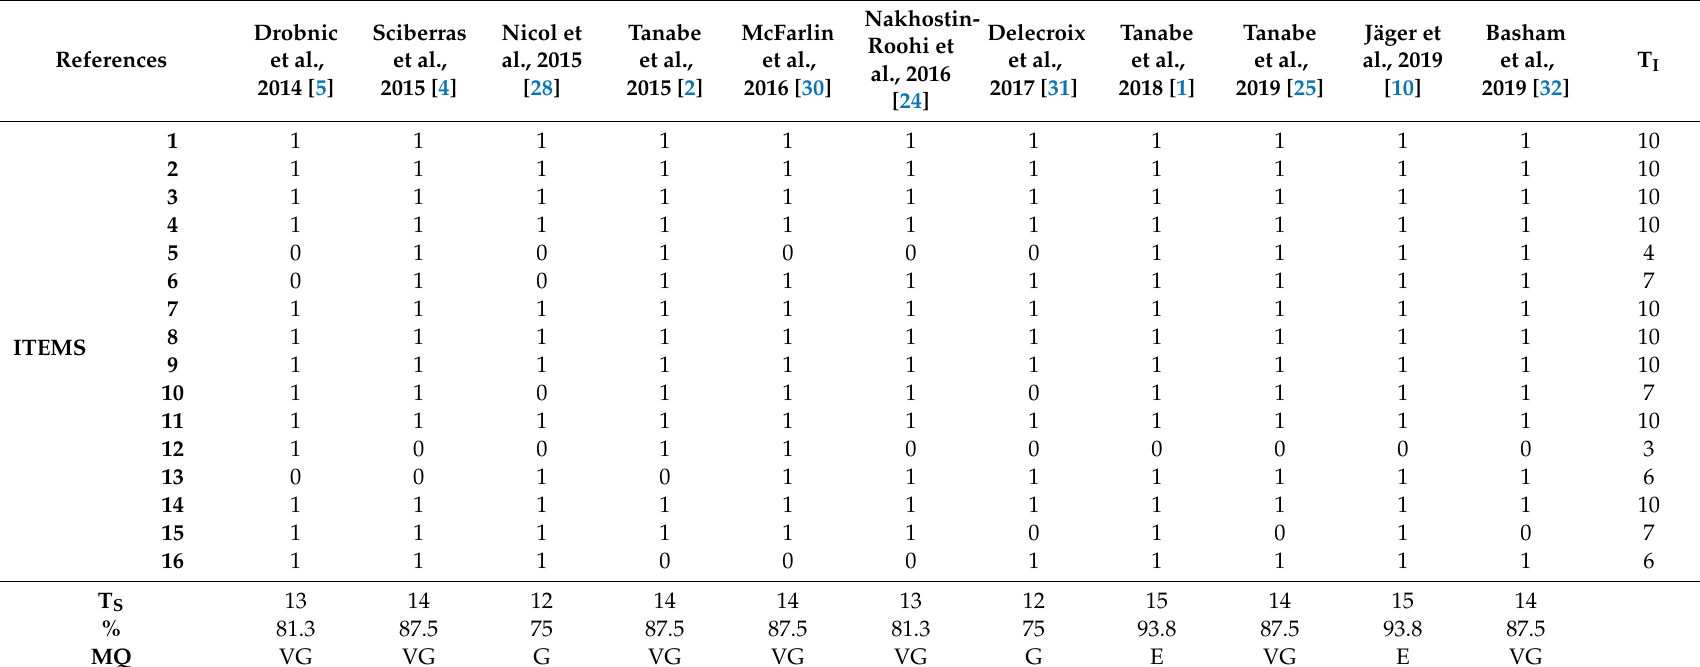
Table 1. Methodological quality of the studies included in the systematic